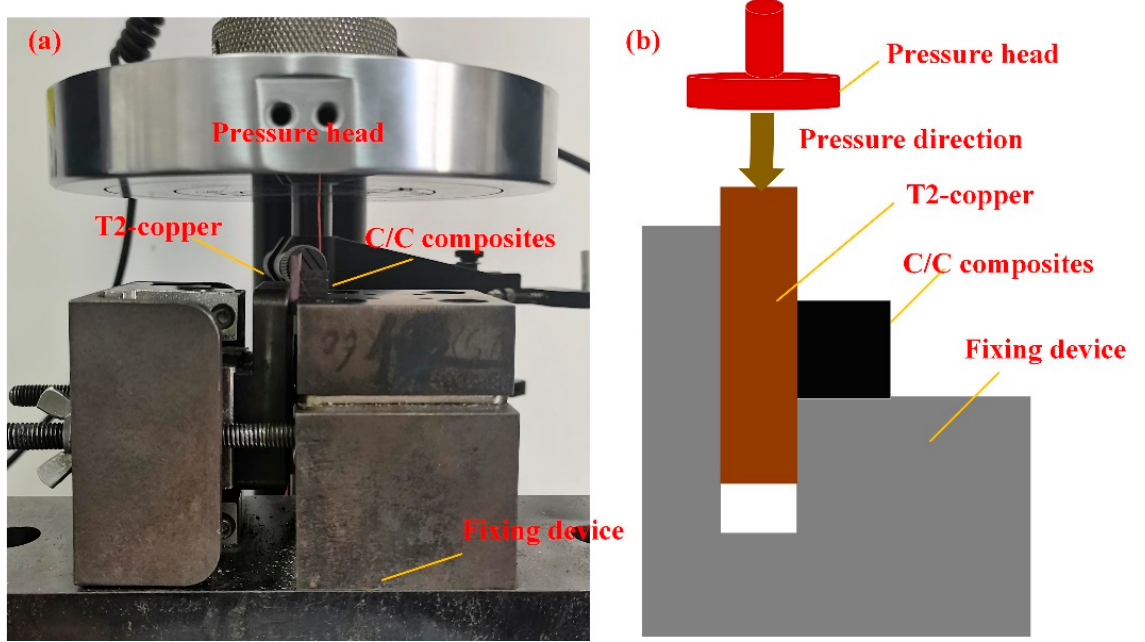
Figure 4. ( a )The actual image of the shear test setup, ( b ) Schematic diagram of the shear test setup. 3.1. The Effect of Ti Content in the Composite Filler Metal on the Joint